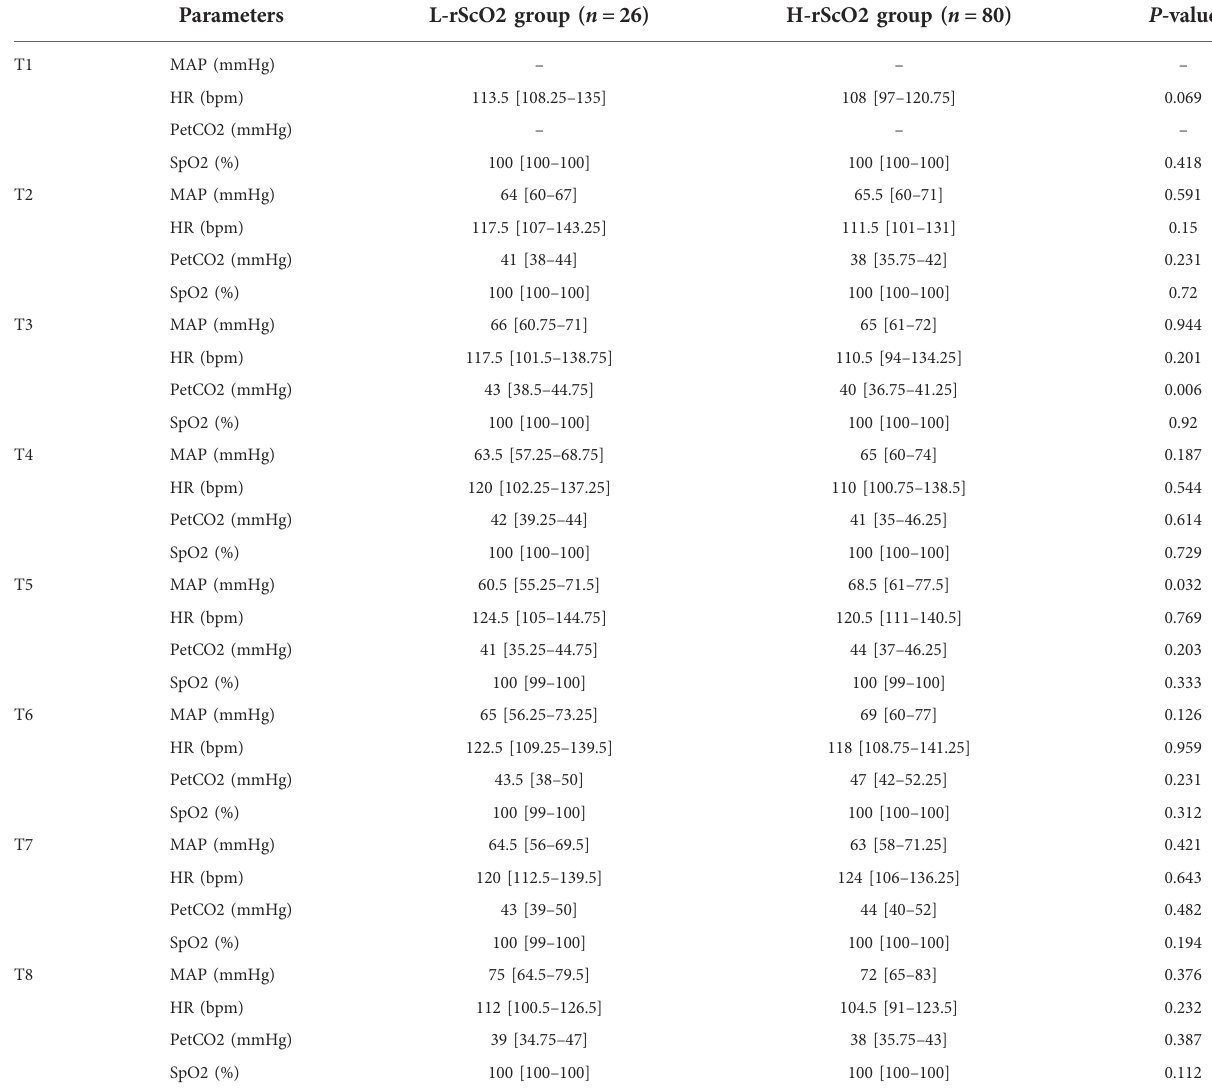
TABLE 3 Intraoperative monitoring data. MAP: mean arterial pressure. HR: heart rate. PetCO2: end-tidal carbon dioxide pressure. SpO2: pulse oxygen saturation.